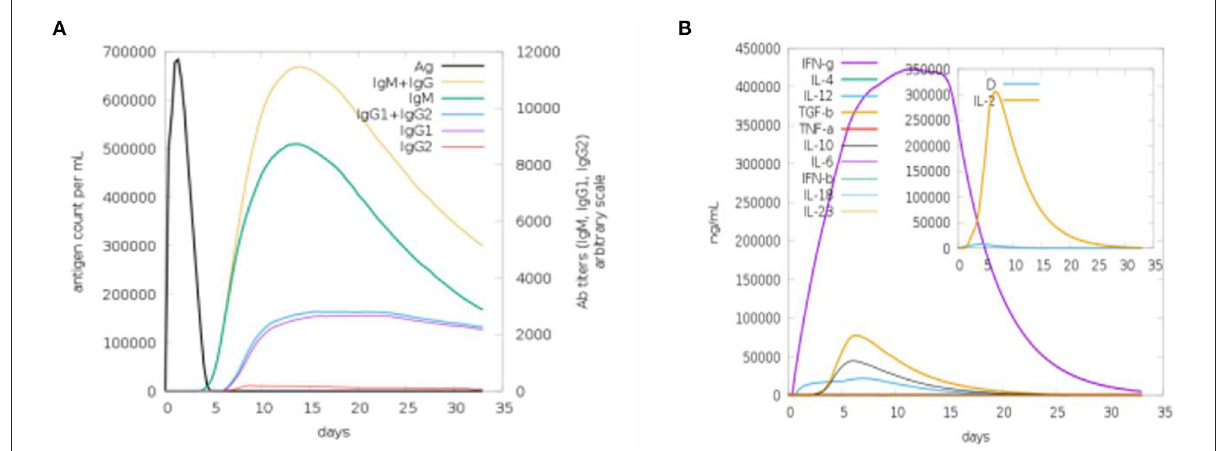
FIGURE9 Computational immune simulation against the vaccine model. (A) Induction of immunoglobulins. (B) Induction of interleukins.